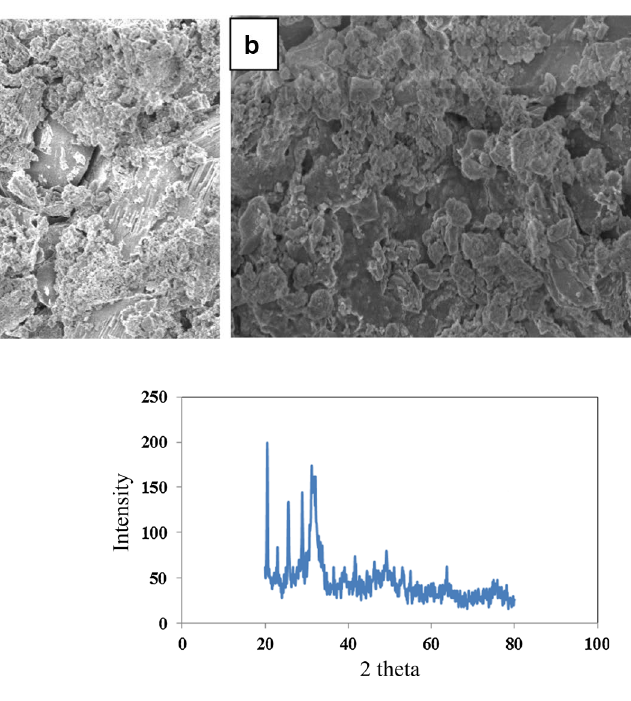
Fig. 14 XRD pattern of CEM facing middle chamber